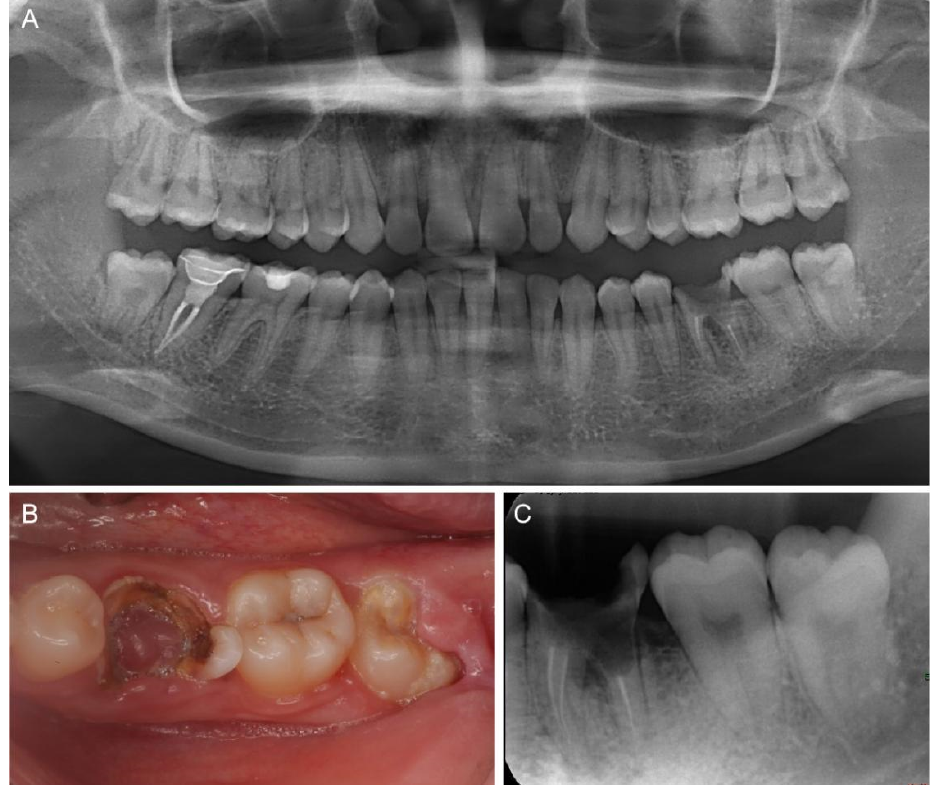
Figure 1. Preoperative examination. ( A ) A panoramic radiograph and ( B ) a clinical photograph showing tooth #36 with extensive caries and pulp polyp, and tooth #38 erupted partly. ( C ) Preoperative periapical radiograph showing tooth #36 with destruction on the floor of the pulp chamber and tooth #38 with completely formed roots.